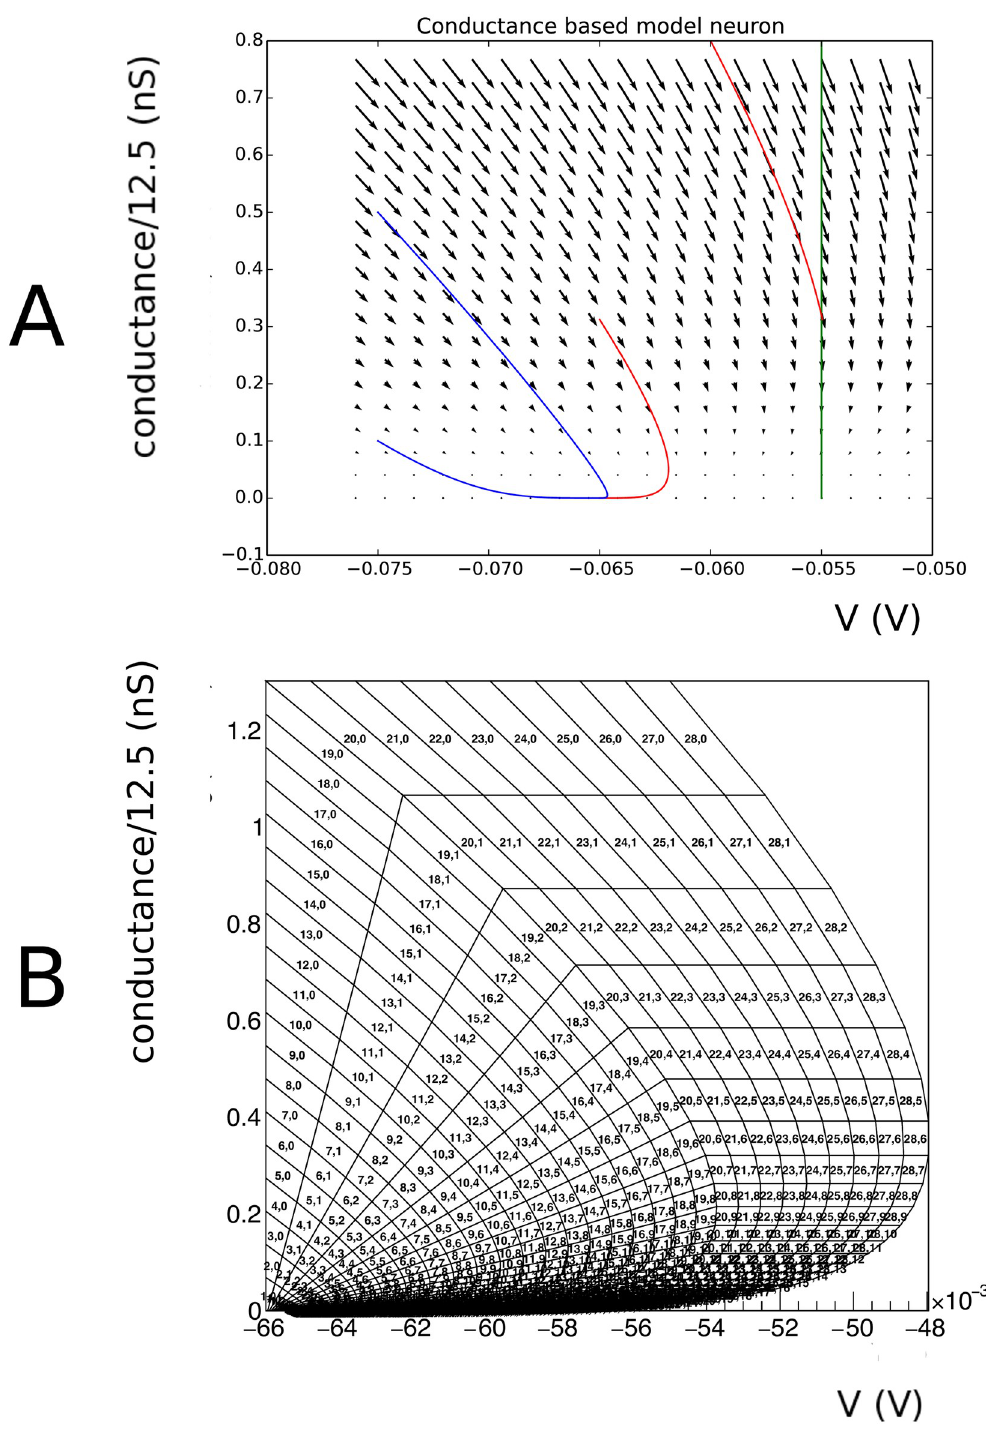
Fig 1. A: Vector field for a conductance based model, along with a few integral curves. At very low conductance, there is a drive towards equilibrium regardless of the initial point. At higher conductance values the drive is dominated by a trend towards the equilibrium potential of the excitatory synapse (0 mV). The blue integral curves demonstrate this. The red integral curve represents a neuron that hits the threshold potential (-55 mV), and subsequently undergoes a reset to the reset potential (-65 mV). This neuron will emit a spike. After reset, it will not hit threshold again and eventually asymptotes to equilibrium potential (-60 mV). B An example grid for the conductance based model. The grid is built from strips.